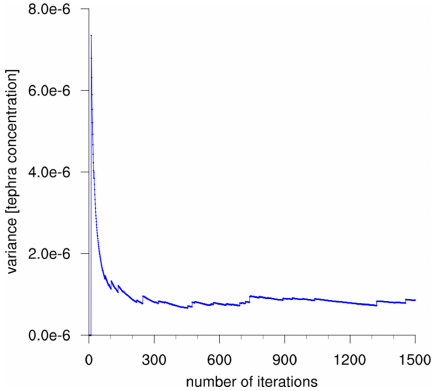
Figure A1. Value of the variance of tephra concentration for a given grid point with respect to the number of scenarios